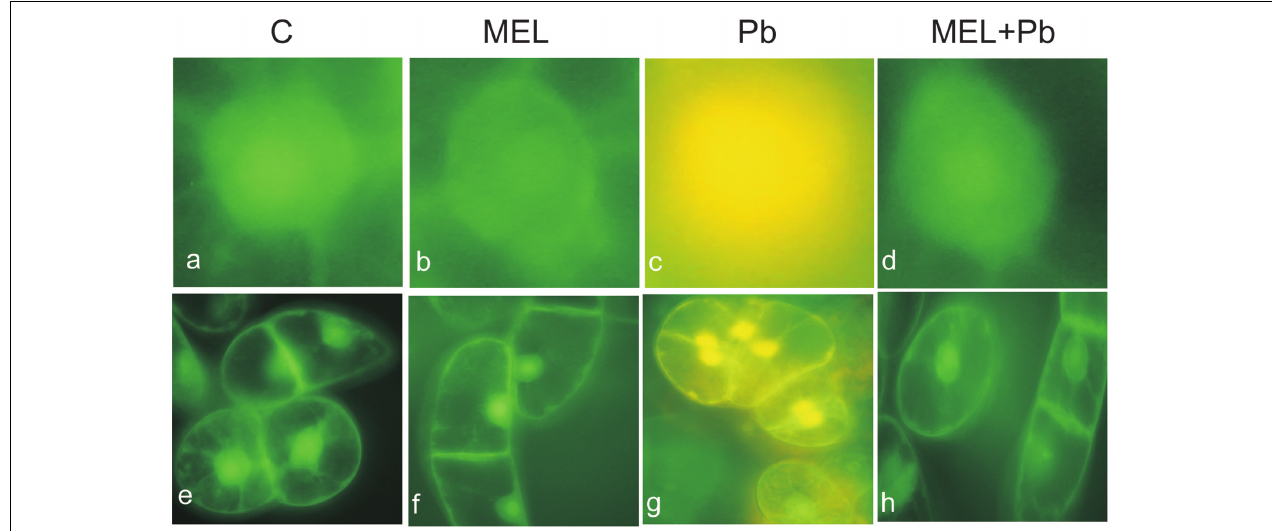
FIGURE 2 | Micrographs of living and dying BY-2 nuclei (a–d) and whole cells (e–h) detected by AO/EB staining. Green nuclei of living cells (a,b,d,e,f,h) , yellow nuclei (c,g) of PCD-dying cells. C, BY-2 cells cultured on LS medium – the control variant; MEL, BY-2 cells cultured on LS medium with 200 nM melatonin added from the beginning of culture; Pb, BY-2 cells cultured on LS medium with 15 µ M Pb 2 + added on the 4th day of culture and MEL + Pb, BY-2 cells cultured on LS medium with melatonin added from the start of the culture and with Pb 2 + added on the 4th day of culture. Micrographs were done 4 h after lead administration.